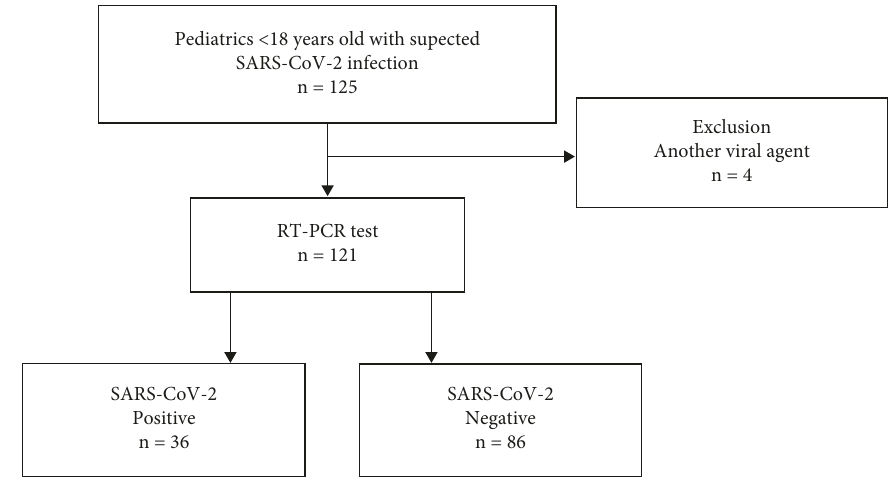
Figure 1: Study flow